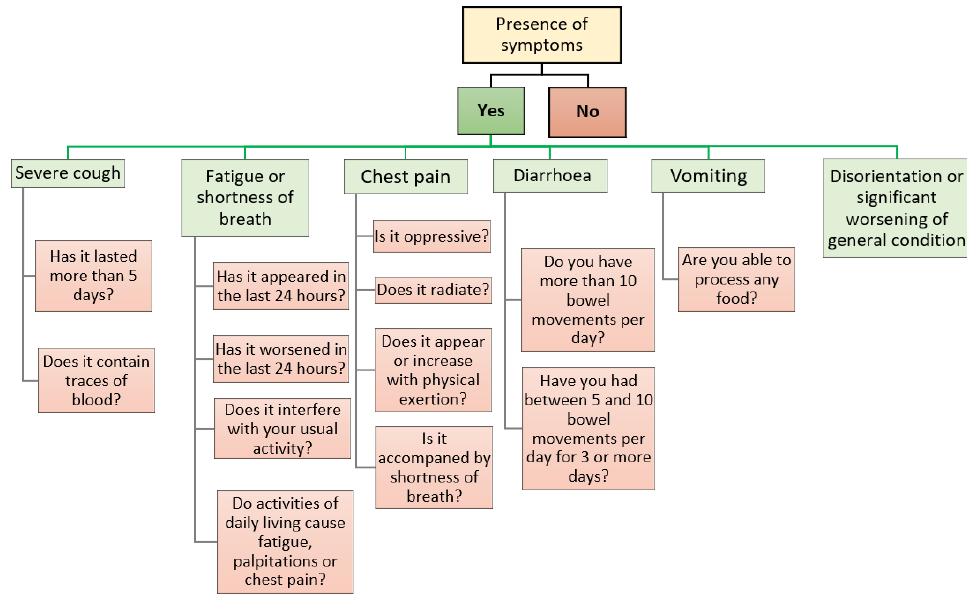
Figure 1. Symptoms and associated clinical questions covered by the ‘‘Home app’’.